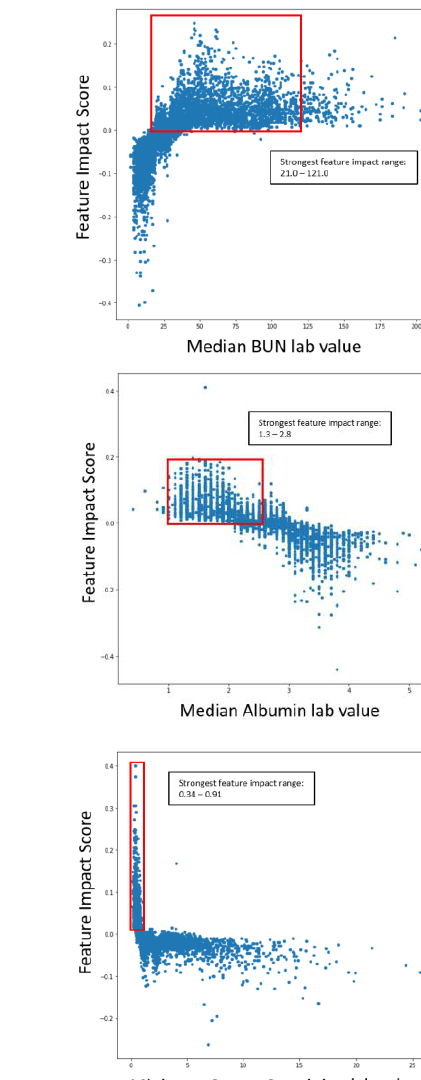
Figure 7. Top 20 most impactful features for COVID-19 survival predictive model. The red data points indicate higher values for the particular feature, while blue data points indicate lower values for the particular feature. A higher feature impact score indicates a higher contribution to a “no survival from COVID- 19” prediction, while a lower feature impact score indicates a higher contri- bution to a “survival from COVID - 19” prediction value.